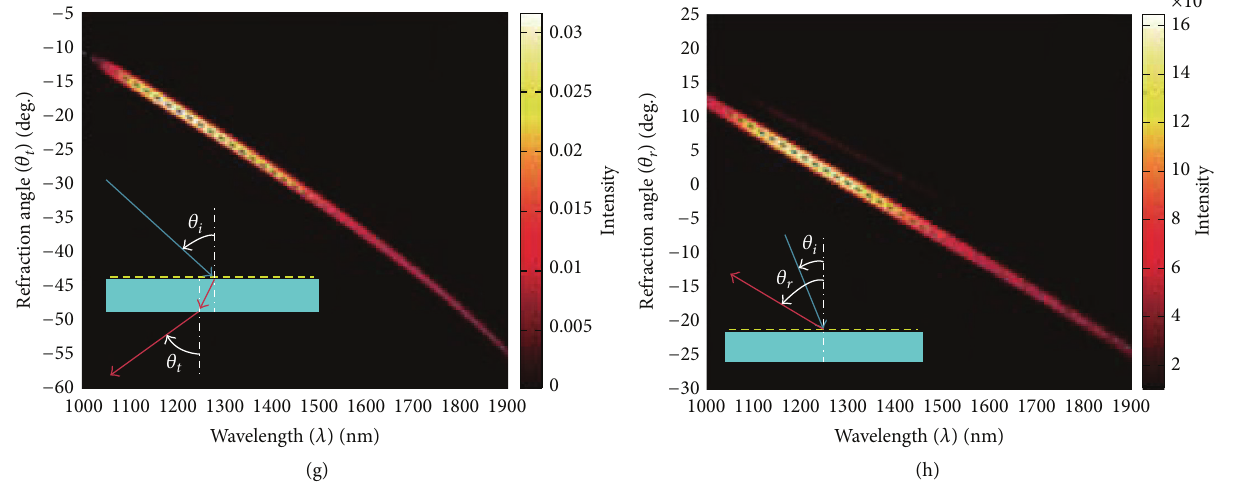
Figure 34: (a) SEM image of a representative antenna array fabricated on a silicon wafer. (b) Schematic experimental setup for 𝑦 -polarized excitation. ((c) and (d)) Measured far-field intensity profiles for the 𝑦 - and 𝑥 -polarized excitations, respectively. (e) Schematic view of a representative antenna array. (f) Scanning electron microscope images of the unit cells of four antenna arrays with different periodicities fabricated on a single silicon wafer. ((g) and (h)) The false-color maps indicate the experimentally measured relative intensity profiles for the antenna array. Figures are reproduced from [134,